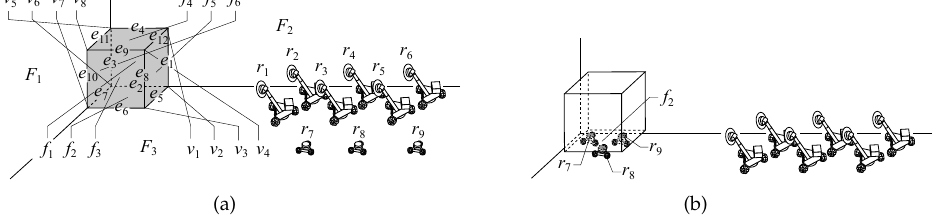
Figure 12. ( a ) Initial mode and ( b ) Target final mode. The targeted object for manipulation is a cuboid. There are two walls and the floor as the environment. We used six pusher robots and three transporter